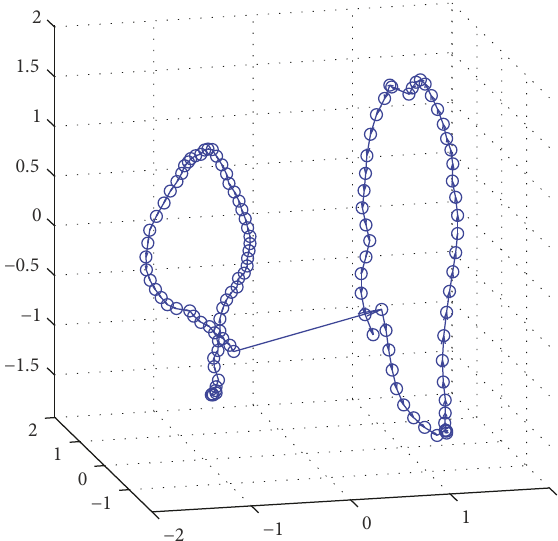
Figure 1: The LD data of the two irrelevant human